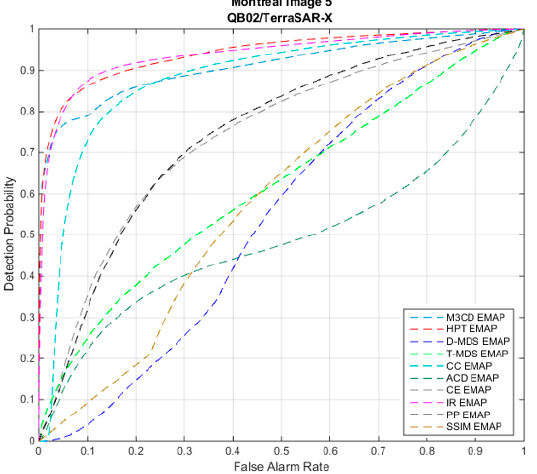
Figure 12. ROC curves for Image Pair-3 with EMAP.